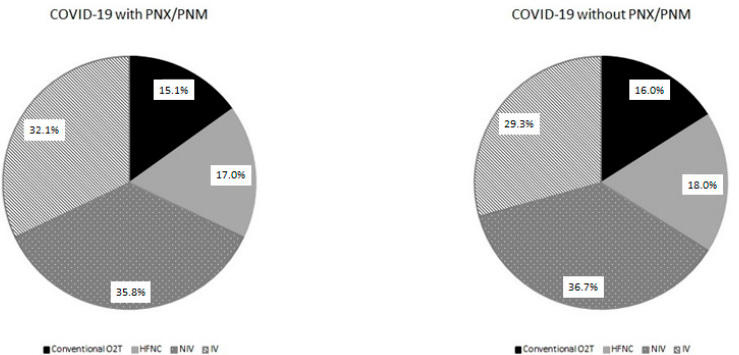
Figure 1. Pie chart reporting the distribution of respiratory support in COVID-19 patients with and without PNX/PNM. Relative percentages are reported in the labels.